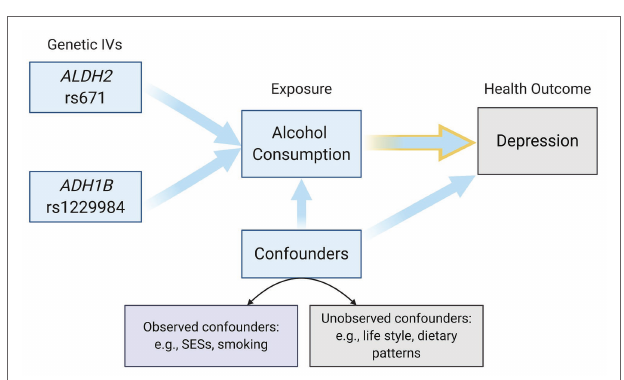
FIGURE 2 | Directed acyclic graph (DAG) of the Mendelian randomization (MR) framework. This DAG illustrated the relationships between the genetic instruments ( ALDH2 rs671 and ADH1B rs1229984), the exposure (Alcohol Consumption), the health outcome (Depression), and the (observed or unobserved)